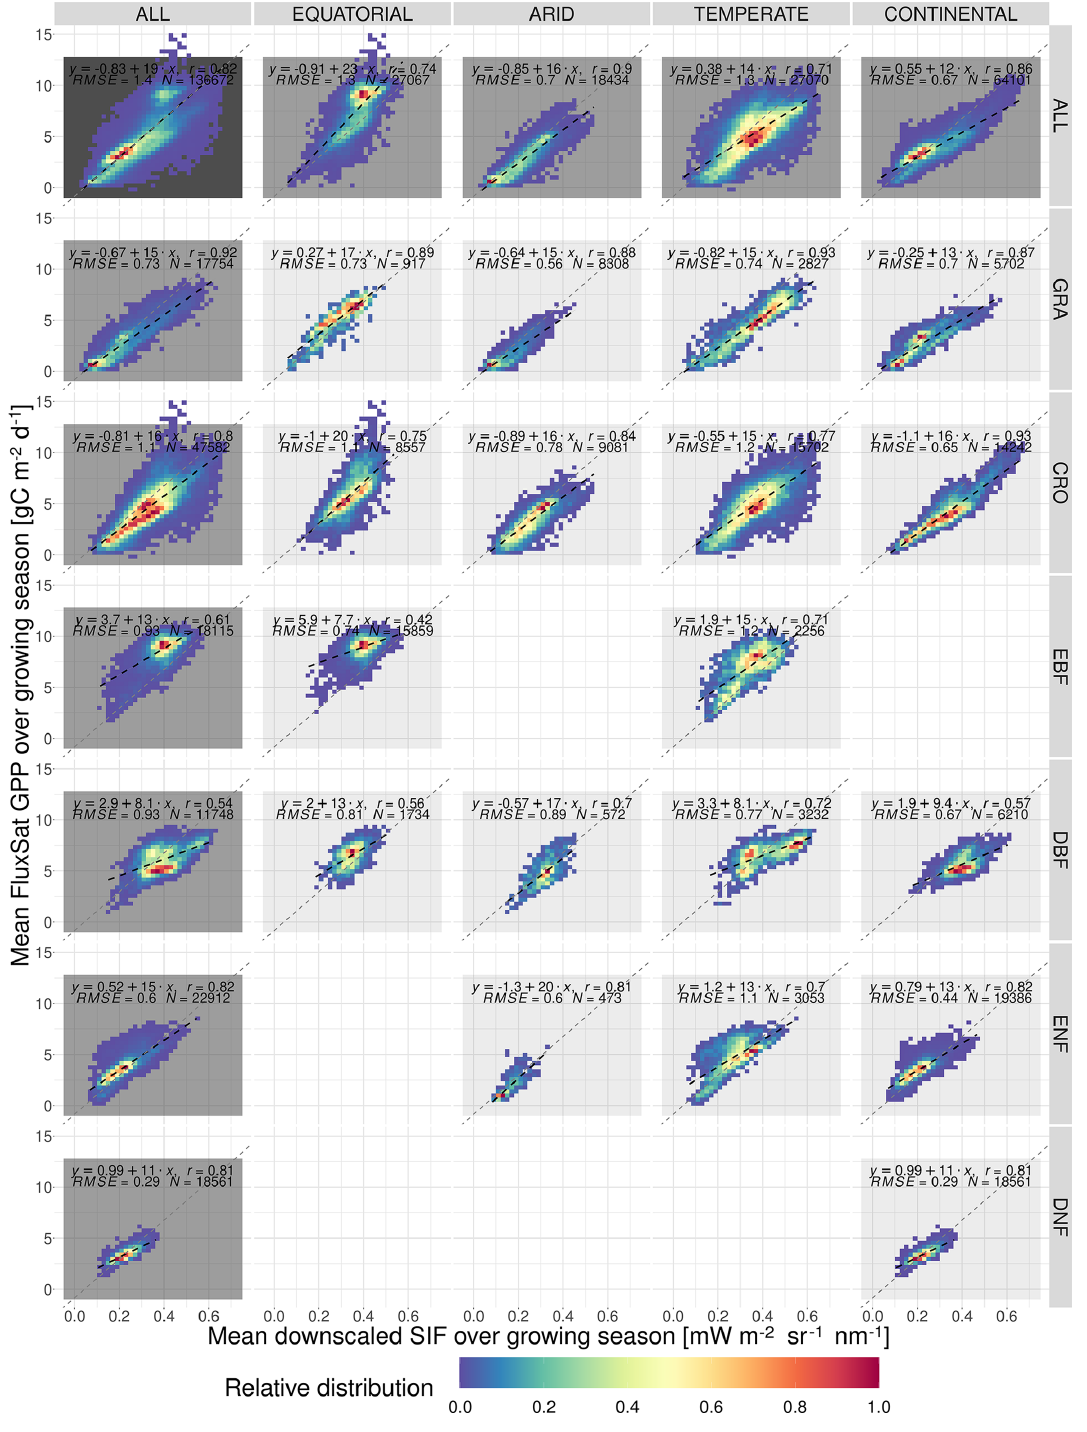
Figure A3. The spatial relationship between the mean growing-season downscaled SIF and FluxSat GPP, broken down into separate Köppen– Geiger climate zones and vegetation cover categories. The plot shows the frequency distribution of pixels into SIF DS –GPP FX bins, relative to the highest-frequency bin in that category. A dashed black line representing a linear model in each category is overlaid and compared to a dotted grey line representing a linear model produced without the breakdown into separate categories (i.e. ALL–ALL). The linear model equation, correlation coefficient r , root mean square error (RMSE) and number of pixels are